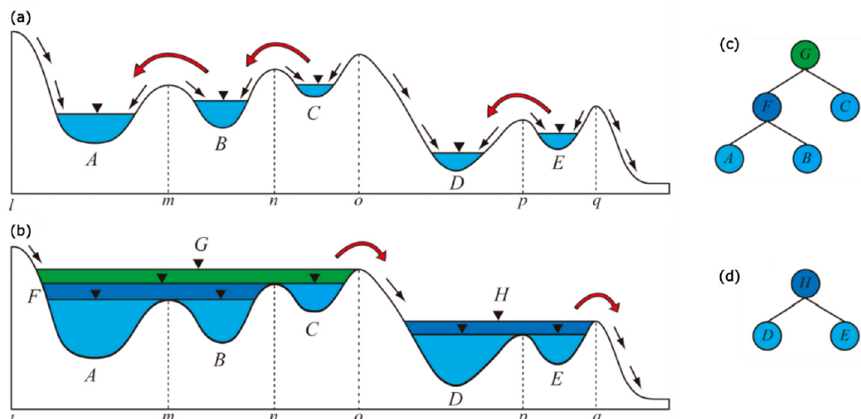
Figure 2. Schematic representation of the Hierarchical Filling-&-Spilling method: ( a ) nested-depression system, and ( b ) blue-spots G and H under fully-filled conditions with illustration of the second-level depressions (F, C, D and E) and third-level depressions (A and B); panels ( c ) and ( d ) report the hierarchical tree of the nested depression systems on the left and the right hand side, respectively, by using different colors for different vertical hierarchical order (adapted from [23]).